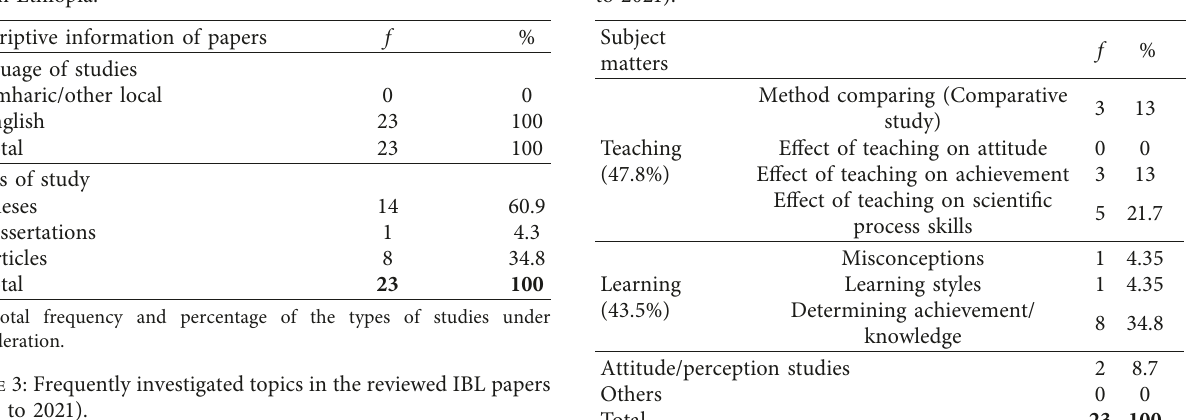
Table 2: Descriptive statistics for the reviewed studies related to IBL in Ethiopia.